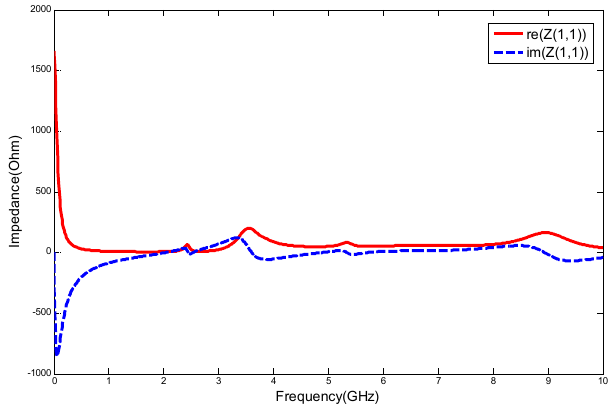
Figure 6. Input impedance curve of the proposed antenna.